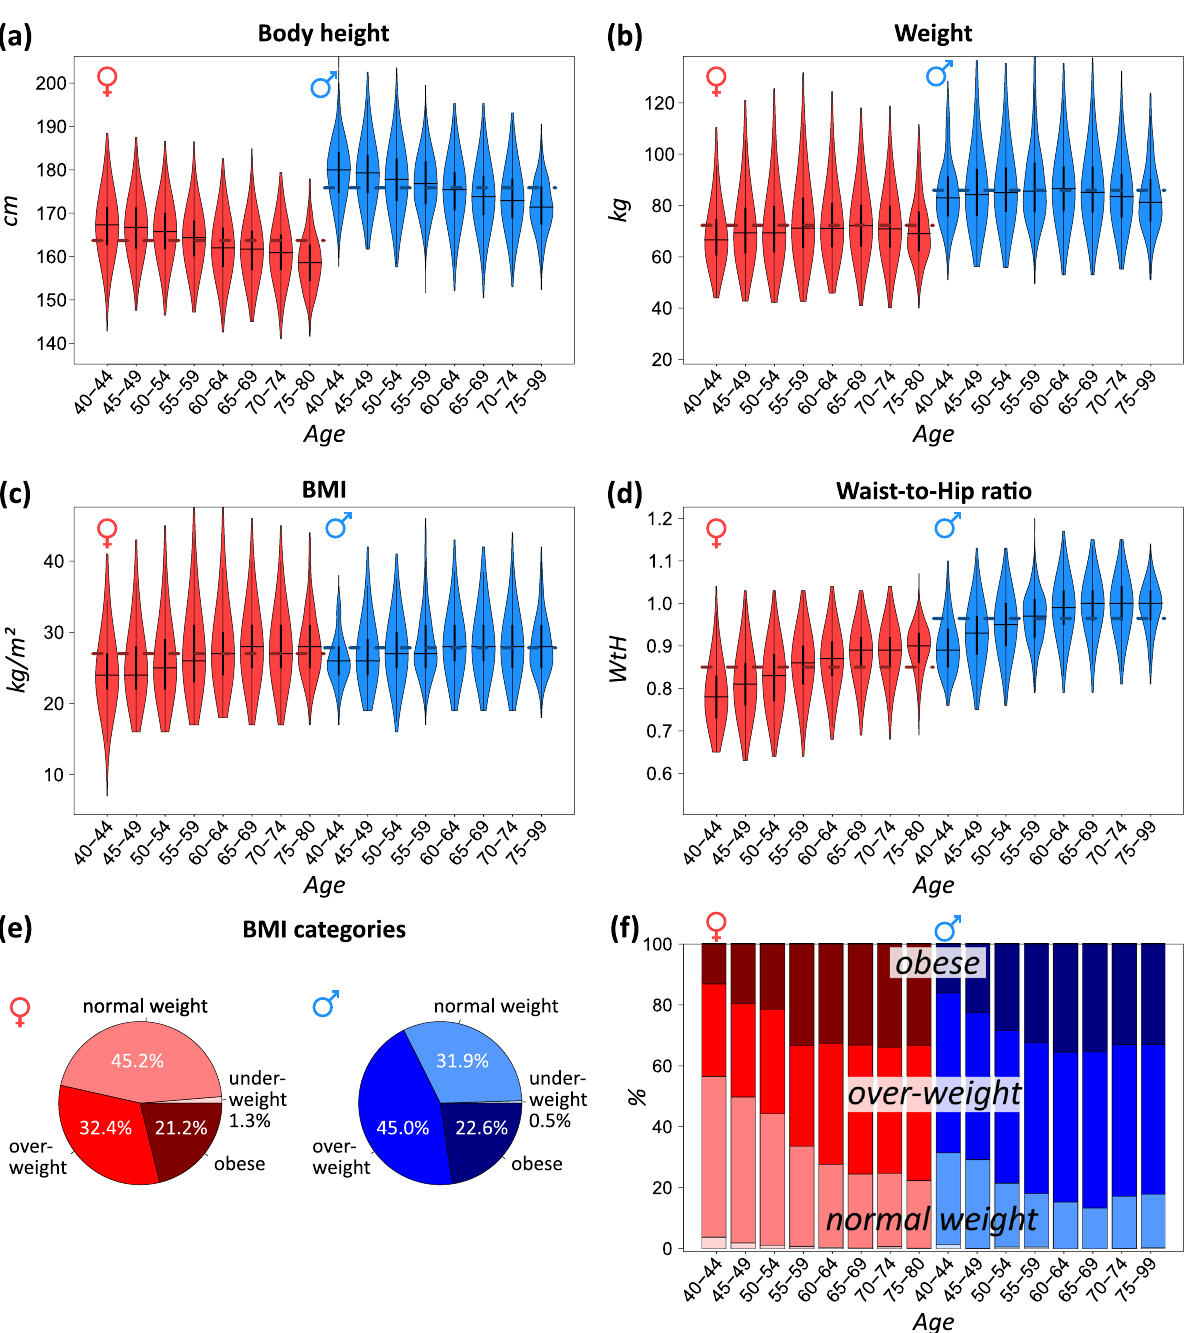
Fig. 1 Classical anthropometric measures as a function of age. a Body height, b weight, c BMI, and d waist-to-hip circumference ratio are given as violin plots strati fi ed by sex and age, respectively. Dashed horizontal lines refer to mean values for women and men, respectively. e The overall distribution of participants classi fi ed as underweight (BMI <18.5), normal weight (18.5 ≤ BMI < 25), overweight (25 ≤ BMI < 30), and obese (BMI ≥ 30) according to WHO classi fi cation 53 . f BMI categories strati fi ed by male body types (M-types) are more uniform. The gender- unspeci fi c (B) body types collect either younger (B1) or older (B2) people and were considered separately for women (B1F, B2F) and men (B1M, B2M). Variability of M-types is higher than that of female ones, except for F3, which collects overweight and obese women of all ages. Age-related changes of BMI are small compared to variabilities of the body types (see below and Supplementary Fig. 2). Two F-types (F3 and F4) and one M-type (M5) collect mainly obese individuals (BMI >30 kg/m 2 ).